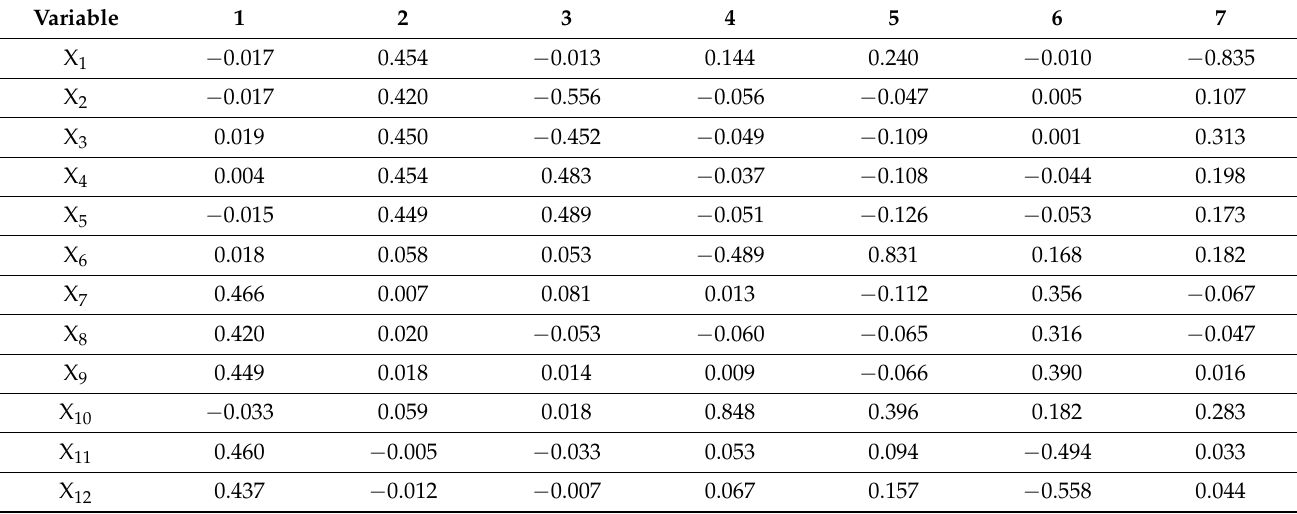
Table 6. Composition matrix.